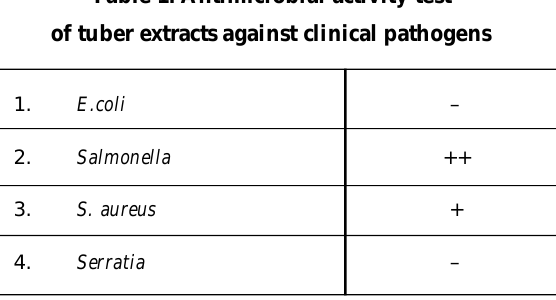
Table 1: Antimicrobial activity test of tuber extracts against clinical